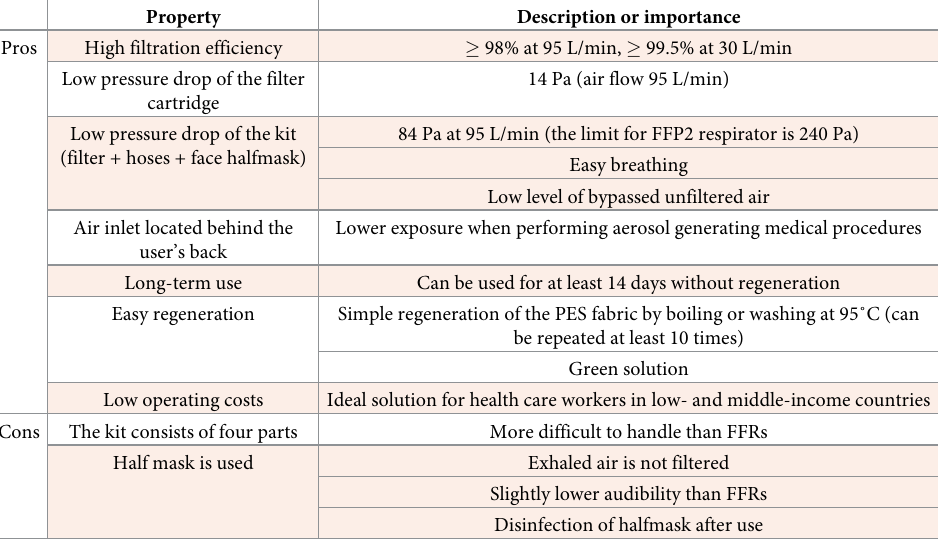
Table 1. Summary of the advantages and disadvantages of the designed filter